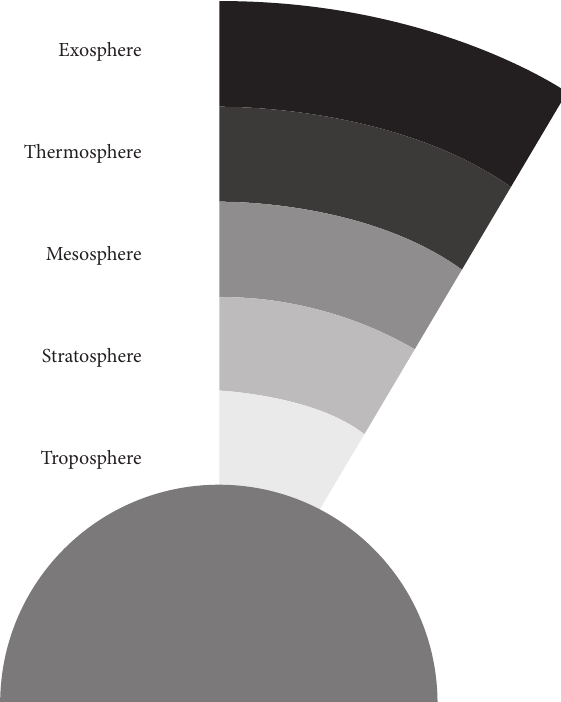
Figure 1: Atmospheric layers with gas